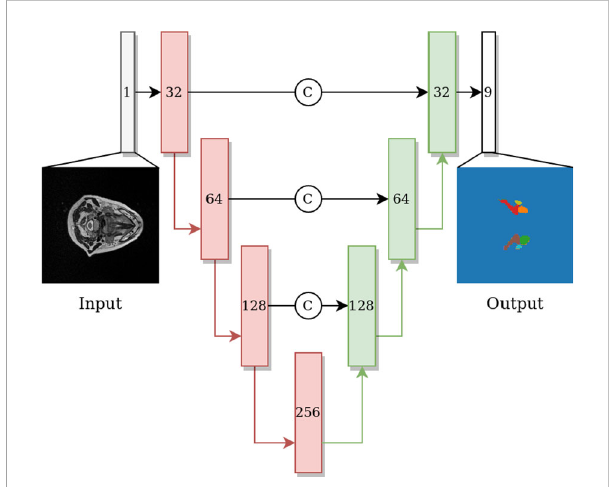
colored in red and blocks on the expanding path colored in green. Each block includes two convolutions, each followed by instance normalization and Leaky ReLU activation, subsequently followed by a max-pool layer (red arrow) or transpose convolution layer (green arrow) on contractive and expanding paths, respectively. The number shown in each block indicates the number of channels of the feature map. Arrows with the letter C indicate